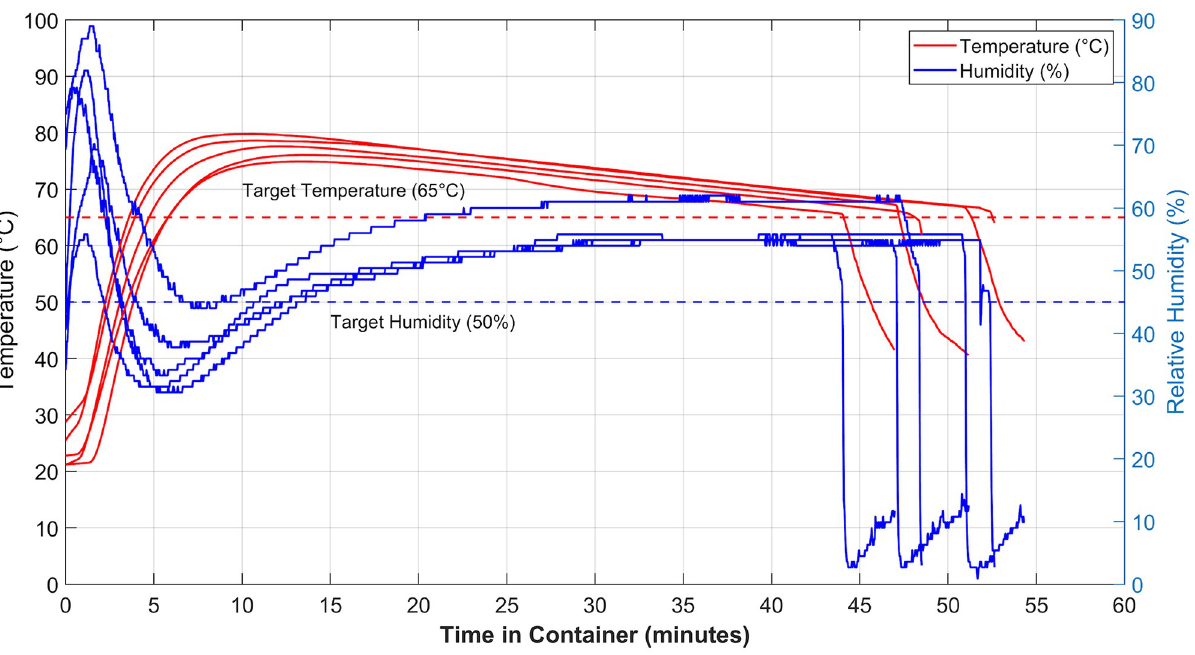
Fig 2. Temperature and humidity inside the container holding N95 respirators during the 5 treatment cycles after which they underwent filtration testing. Rapid decrease in humidity in the end is due to opening of the container at the end of the decontamination treatment.